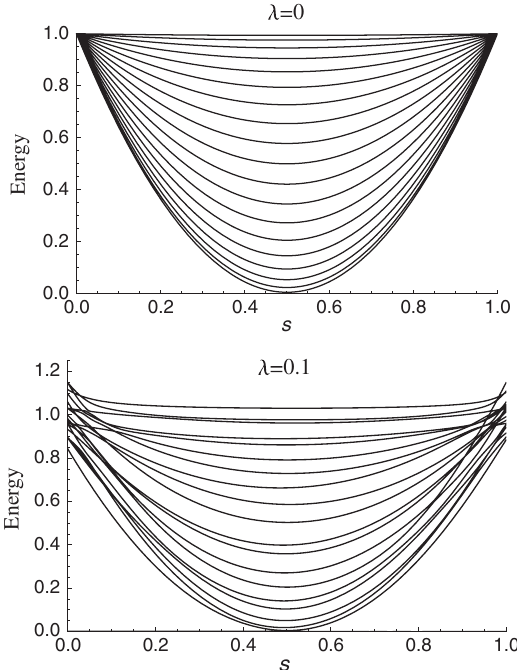
FIG. 8. Static perturbations. Consider a quantum wire with repeated Hadamard gates, but where the individual interactions in, for example, Eq. (23) are randomly perturbed by a random amount in the range of (cid:1) (cid:5) to (cid:5) . This plot is done for a wire of length 20. This model can be mapped to the transverse Ising model, and above we plot the energy of the free fermions that occur in this model. One sees that, while the energy cost for each fermion with the perturbed field is modified, qualitatively the cost for each individual fermion remains approximately the same. This result implies that the model will behave similarly to the unperturbed model: In the absence of other errors, the worst this can do is cause a level crossing near s ¼ 1 = 2 , which will at most introduce a constant number of errors in the model. Furthermore, the effects of other errors occurring on this per- turbed model will be similar to how we argue they will act in the main text. In particular, there will be a constant fraction of errors occurring when the system is coupled to a thermal bath and obeys detailed